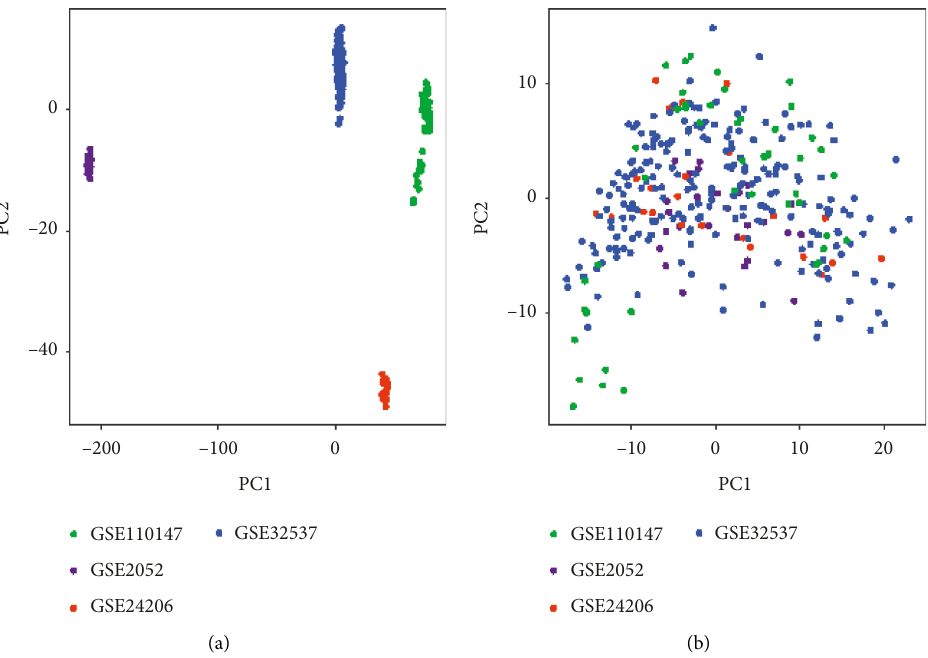
Figure 1: Principal component analysis of the 4 gene expression datasets. (a) Data before normalization. (b) Data following